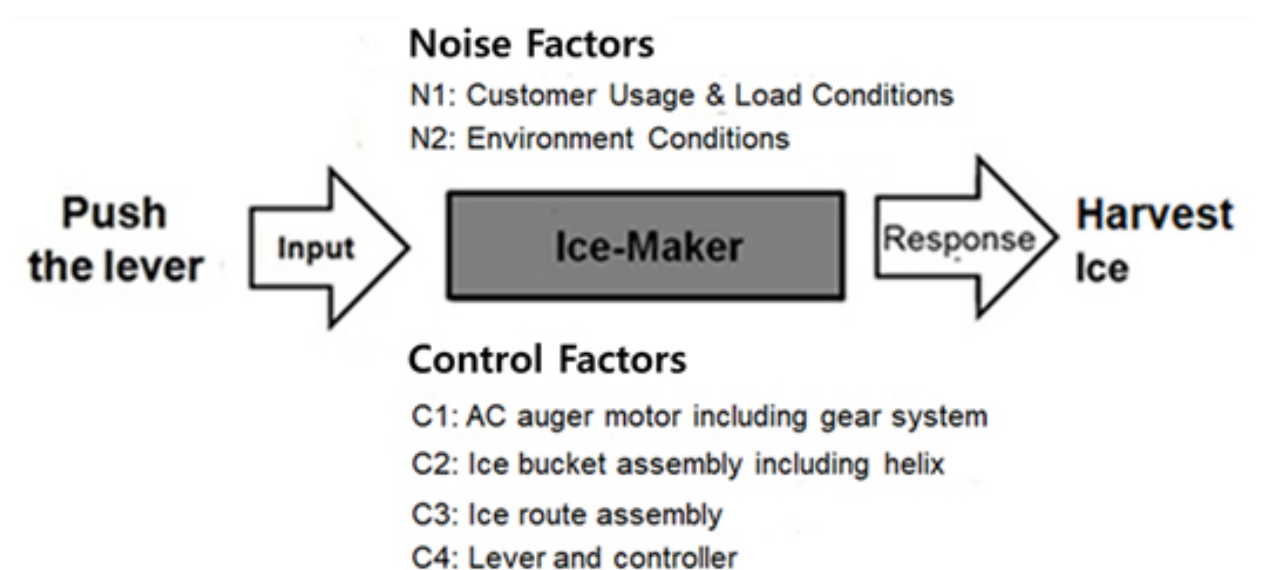
Figure 3. Intended function of ice-maker adding gear system (instance).